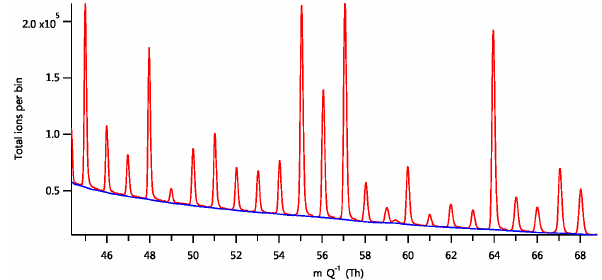
Figure 1. Example of a mass spectral baseline determined using the methodology described in the